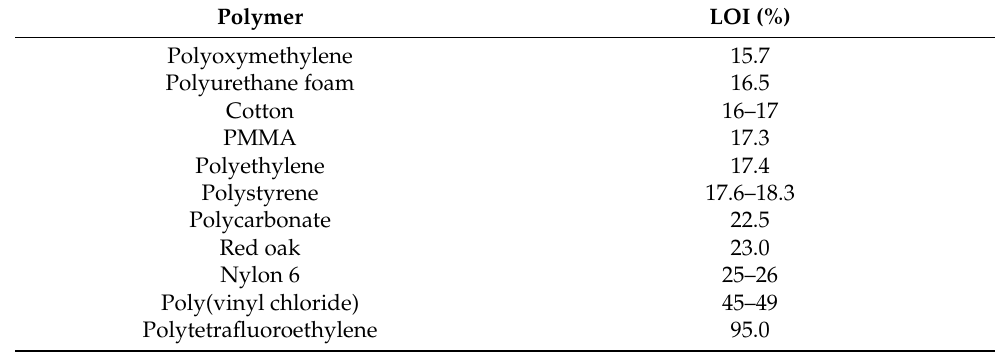
Table 3. LOIs of polymeric materials. Reprinted with permission from Ref. [50]. Copyright 1988,